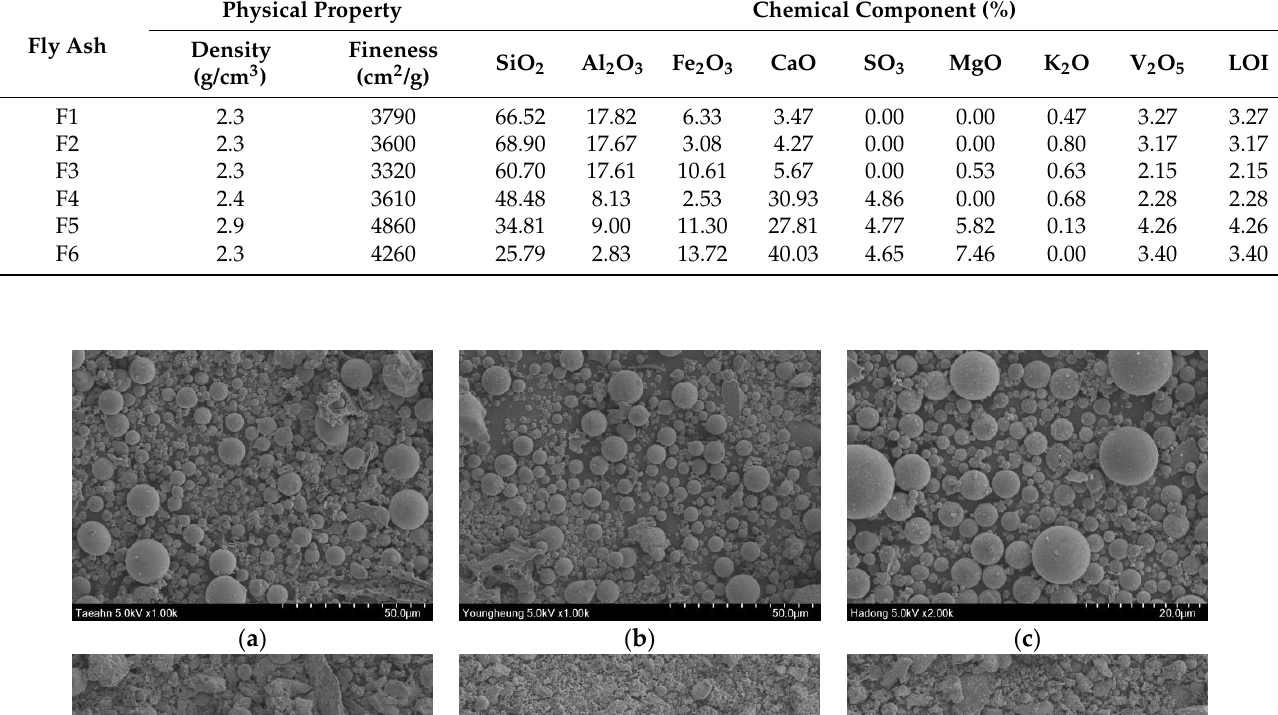
Table 1. Physical properties and chemical components of fly ashes.